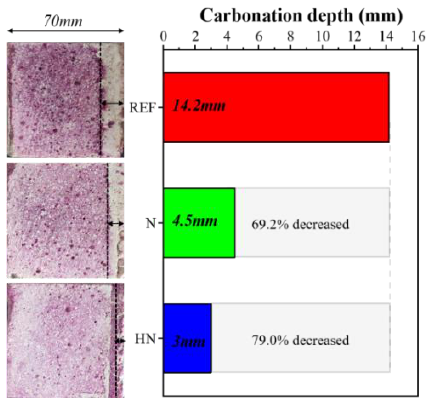
Figure 4. Carbonation depth of different samples after 28 days of carbonation.